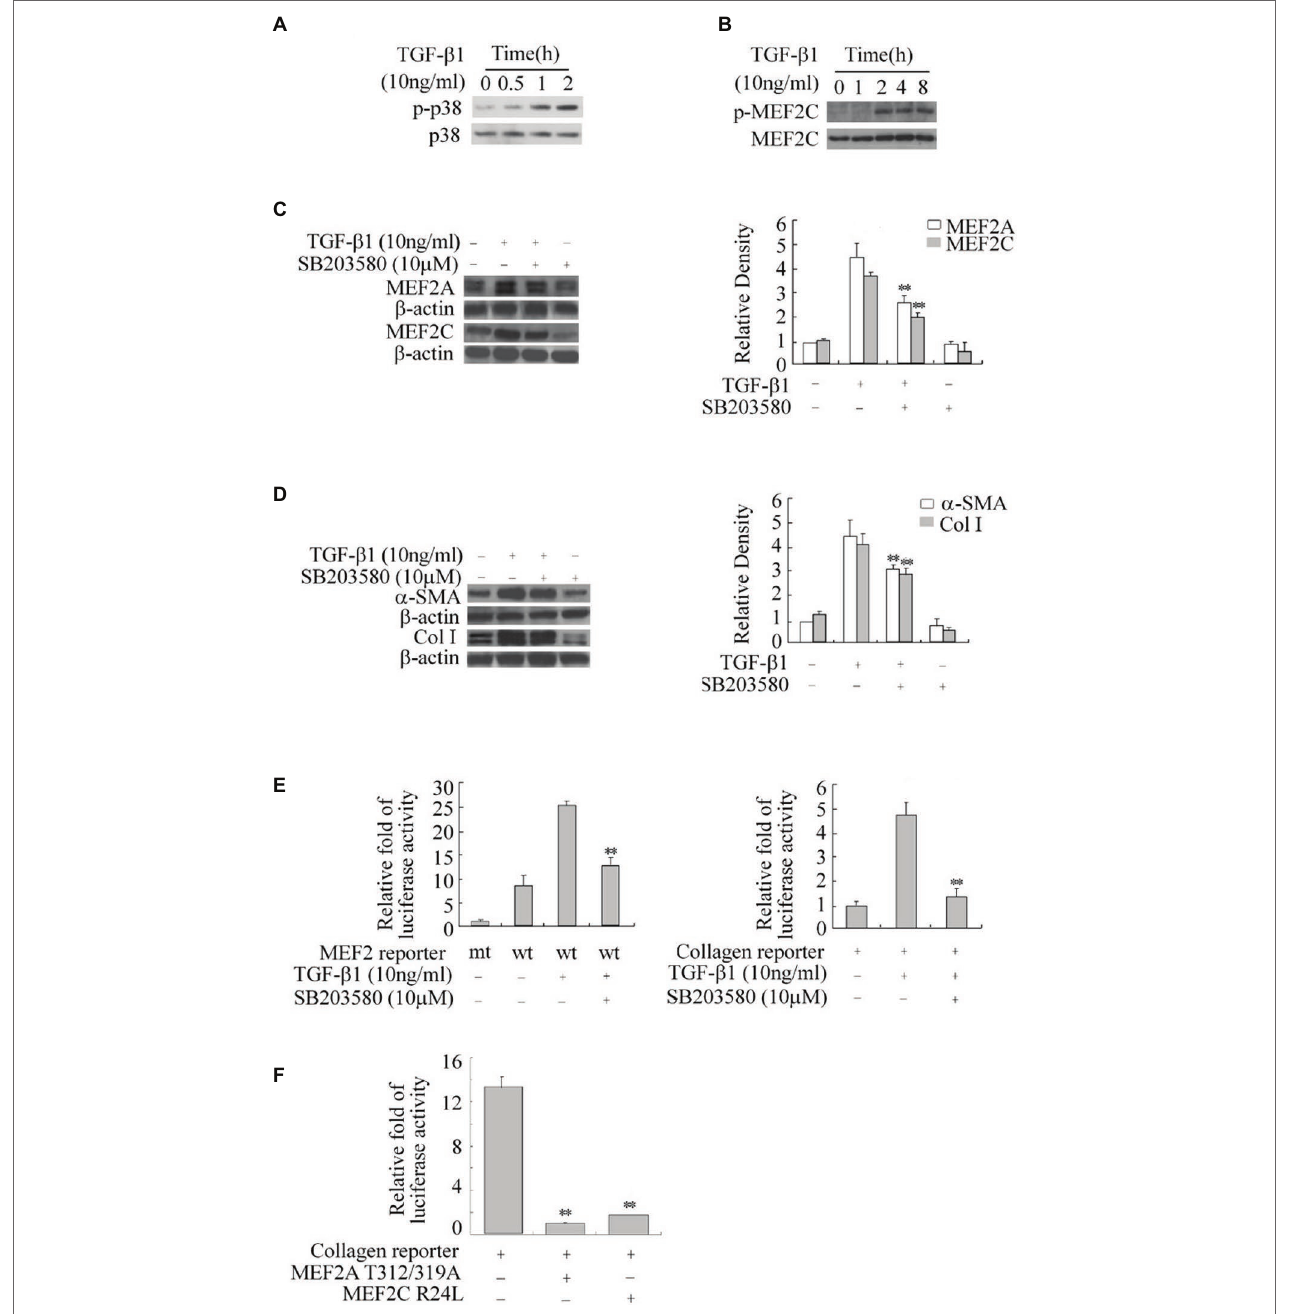
FIGURE 4 | Regulation of the expression of MEF2, α -SMA, and collagen I by TGF- β 1-p38 MAPK in HSCs. (A) Activation of p38 by TGF- β 1. H-HSCs were treated with TGF- β 1 for different lengths of time. Levels of phosphorylated p38 (p-p38) and total p38 were determined by western blot. (B) TGF- β 1-induced phosphorylation of MEF2C. Levels of p-MEF2C and total MEF2C were determined by western blot. (C) Inhibition of TGF β 1-induced regulation of MEF2 by the p38 inhibitor. Primary H-HSCs were pretreated with SB203580 (p38 inhibitor) or vehicle for 24 h and treated with TGF β 1 during the last 2 h. MEF2A and MEF2C were determined by western blot. (D) Inhibition of TGF β 1 induced- α -SMA and collagen I expression by p38 inhibitor. The assays were performed as described in (C) ( n = 3, ** p < 0.01 TGF- β 1-treated samples with SB203580 vs. without SB203580). (E) Inhibition of TGF β 1 induced MEF2 transactivation activity and collagen I reporter in H-HSCs. H-HSCs on day 5 in culture were transfected with mutated (mt) or wild type (wt) MEF2 reporter overnight, and then treated with TGF β 1 for 2 h with or without SB203580 pretreatment over 24 h. The luciferase assay was performed ( n = 3; ** p < 0.01 wild-type reporter induced by TGF- β 1 with SB203580 treatment vs. without treatment). (F) Inhibition of collagen I reporter by blocking MEF2. The collagen I reporter gene assay was determined at day 7 in primary culture, 48 h after transfection with the co-expression of dominant negative MEF2 as indicated ( n = 3, ** p < 0.01 vs.